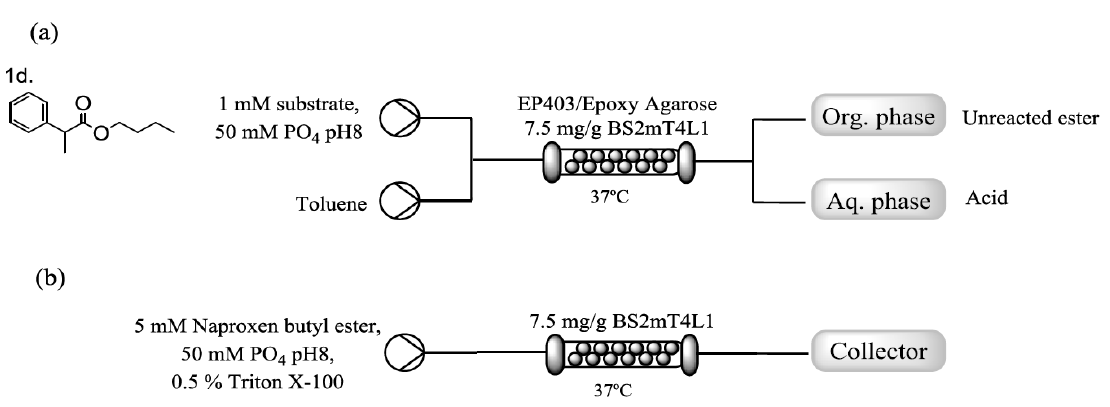
Figure 3. ( a ) Scheme of the setup of the flow reactor with toluene and ( b ) outline of the final setup for the enantioselective hydrolysis of naproxen.